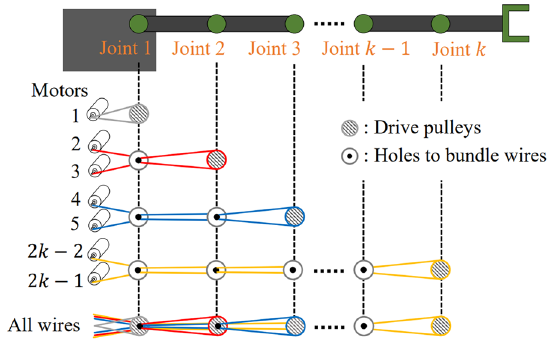
Fig. 3 Arrangements of tendons, holes, and pulleys of the arm